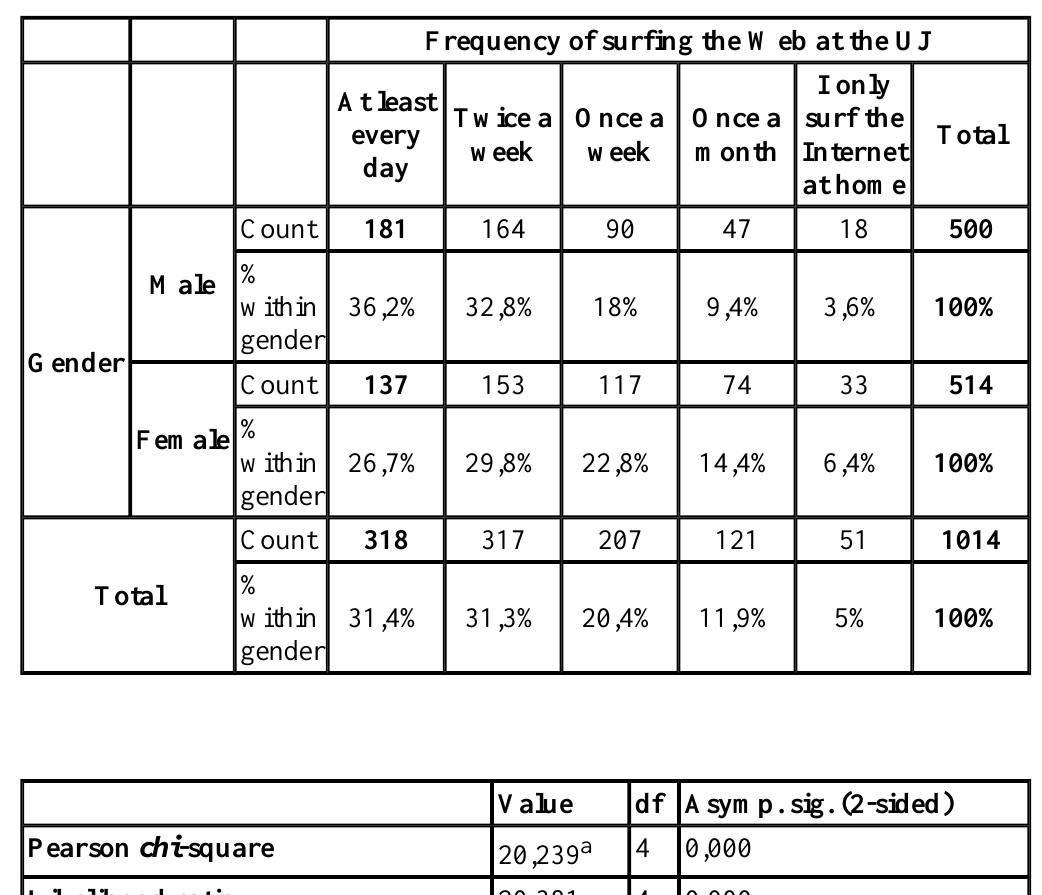
Table 3 Cross tabulation of gender difference for Question 8 (surfing the Web at the